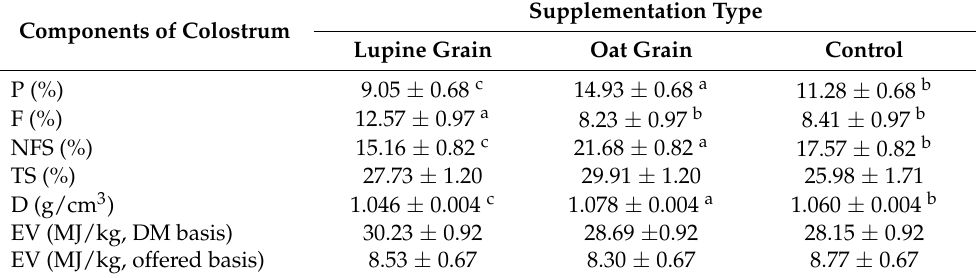
Table 2. Percentage of protein (P), fat (F), non-fat solids (NFS), total solids (TS), and density (D), deter- mined in the colostrum of Merino Precoz ewes (least squares mean ± standard error), supplemented with different grains. Components of